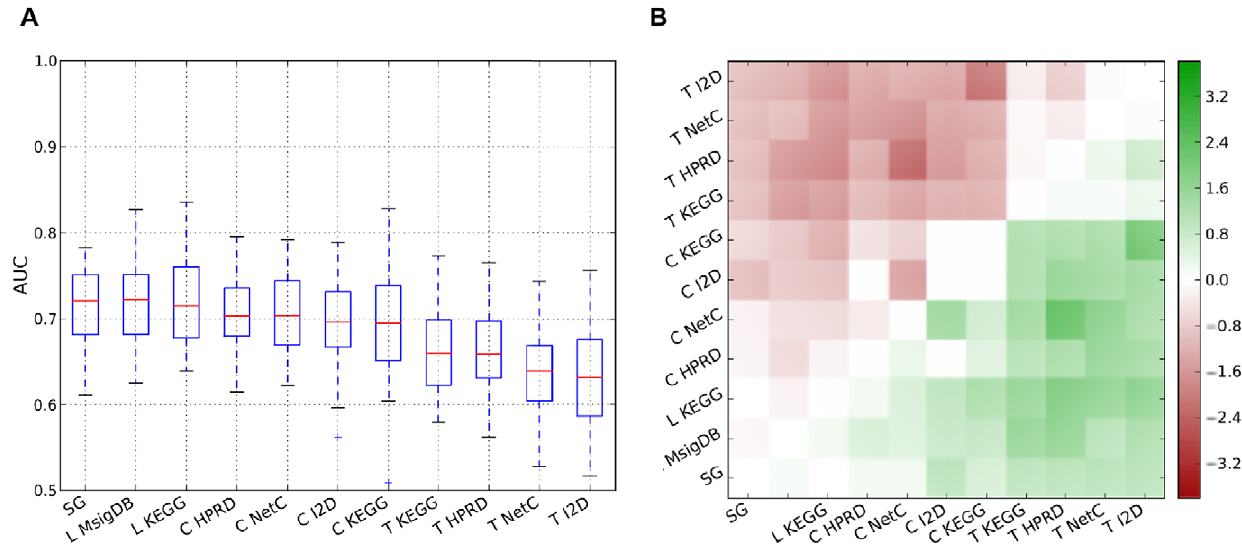
Figure 2. Performance of the NMC employing single genes and composite features constructed from different secondary data sources. For each combination of feature extraction method and secondary data source and each pair of data sets we obtained one AUC value resulting in 30 AUC values per combination. The number of features for each classifier was determined in the cross-validation procedure (CV- optimized). A: Each box plot shows the median, the 25% and 75% percentiles and the standard deviation of the 30 AUC values. Outliers are depicted by crosses. The boxes are sorted in descending order according to the median. B: This panel shows the result of pairwise comparisons between all combinations of feature extraction methods and secondary data sources. If, for a given combination of training and test data set, the AUC value of classifier i is higher (lower) than the AUC value of classifier j on the same test data set, it is counted as a win (loss) for classifier i . Element ( i , j ) in the matrix represents the log 2 ratio of wins to losses of method i compared to method j . Green indicates an overall win, red an overall loss and white represents draws. The rows and columns are sorted as in Panel A. Abbreviations: SG: Single genes; C: Chuang ; L: Lee and T: Taylor